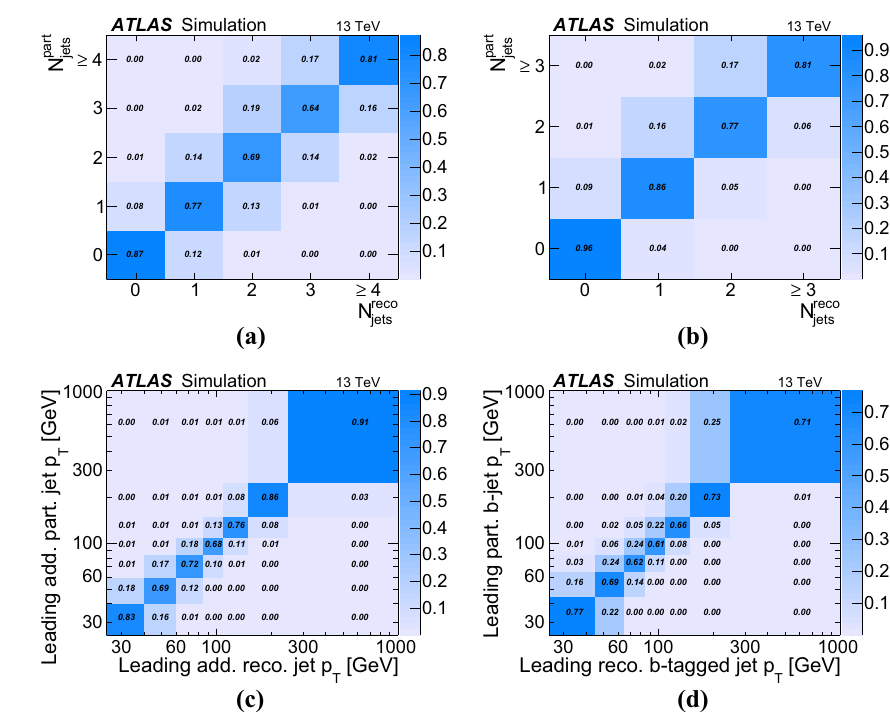
Fig. 3 Unfolding response matrices to match distributions (jet multiplicity, jet p T ) at reconstruction level to particle-level distributions in the fiducial phase space. Only events that fulfil the reconstruction- (particle-) level selection are included.